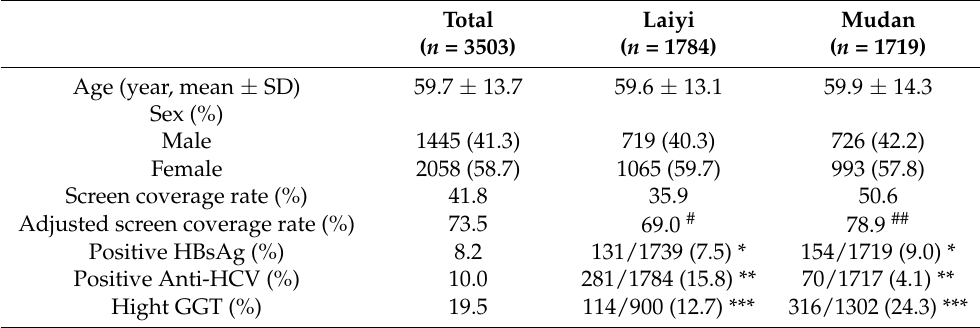
Table 1. Demographics, screen coverage rate and prevalence of hepatitis B virus surface antigen (HBsAg), antibody to hepatitis C virus (anti-HCV) and high gamma-glutamyl transferase (GGT). Total